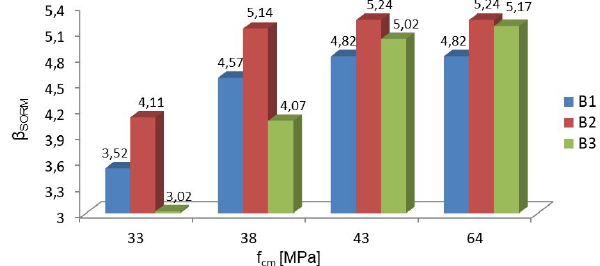
Figure 6: Impact of concrete strength on the reliability index of analysed